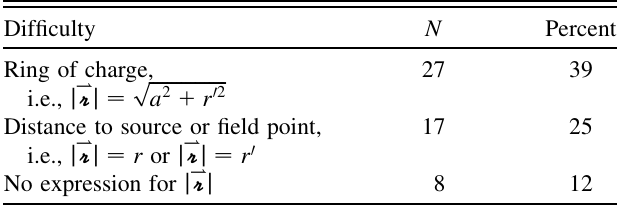
TABLE II. Difficulties expressing the magnitude of the differ- ence vector ( r ). Percentages are of just the students who had difficulties with r (47% of 148, N ¼ 69 ). Codes are not exhaus- tive but represent the most common themes; thus, the total N in the table need not sum to